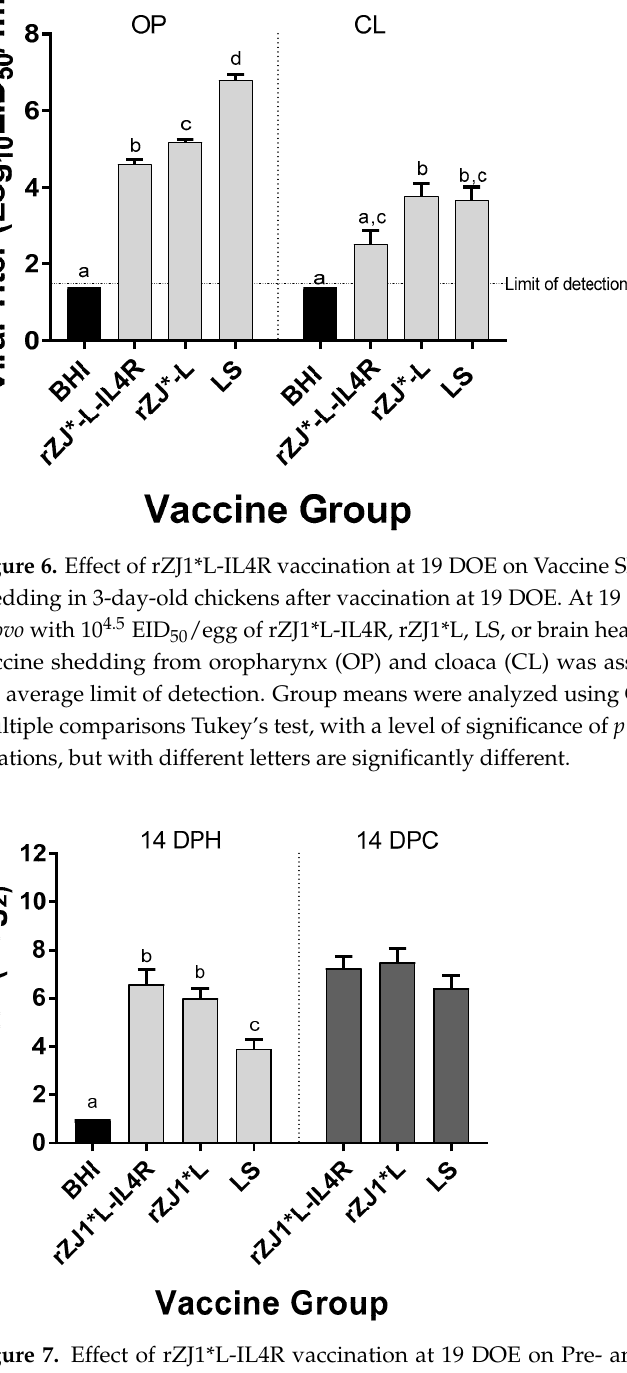
(BHI) ( p ≤ 0.05) (Figure 8a,b). Post-challenge survival was 100% for all vaccinated groups, compared to 0% for non-vaccinated chickens. No adverse clinical signs were observed in vaccinated chickens. Sham vaccinated-challenged chickens were depressed, as noted by their ruffled feathers and reluctance to move when approached.